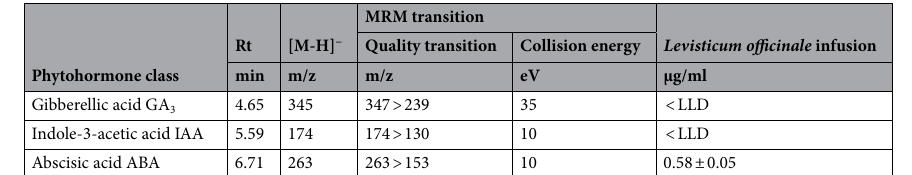
Table 3. Phytohormones in water extracts from Levisticum officinale obtained by boiling (infusion) (average ± SD). < LLD—below limit of detection.